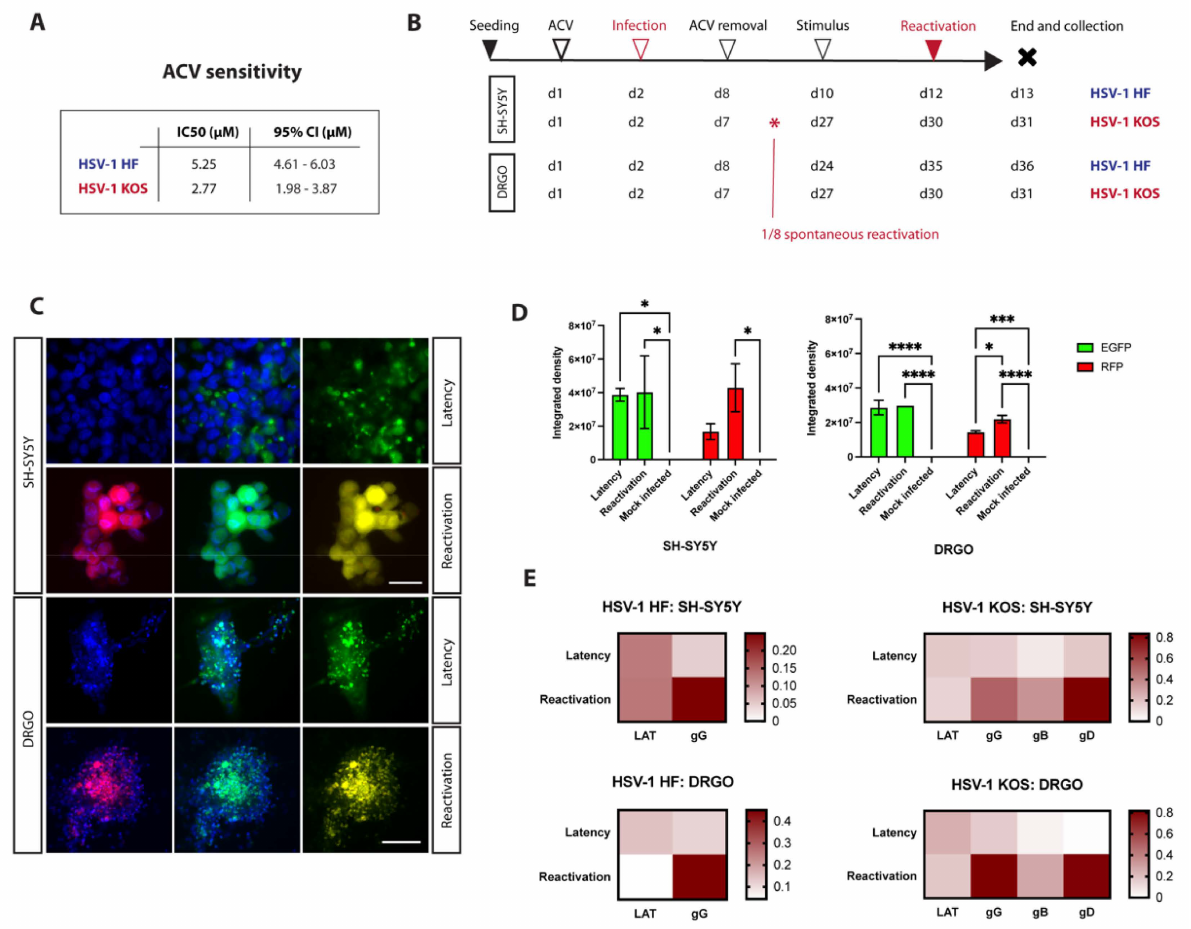
Figure 4. HSV-1 latency and reactivation protocol setup. ( A ) ACV phenotypic assay performed on HSV-1 laboratory strain (HF) and recombinant virus (KOS). ( B ) Schematic representation of different protocol timing tested on SH-SY5Y and DRGOs, using both virus strains. ( C ) Immunofluorescence analysis of SH-SY5Y and DRGOs during virus latency and reactivation. Virus protein gC (red, first column) is transcribed only during productive infection, while ICP0 promoter (green, second column) is active during both stages of infection. Total nuclear DNA is counterstained with Hoechst (blue); the last column shows the merge of green and red signals. Scale bars: SH-SY5Y, 30 µ m; DRGO, 200 µ m. ( D ) Levels of ICP0 (green fluorescent signal) and gC (red fluorescent signal) expression measured as integrated density values for SH-SY5Y and DRGOs during latency and reactivation. Mean ± SD is reported, * p < 0.05, *** p < 0.001, **** p < 0.0001. ( E ) Heatmap showing virus gene expression analysis of SH-SY5Y and DRGOs during latency and reactivation using both HSV-1 strains (dark red = high expression; white = no expression). Each condition was tested in